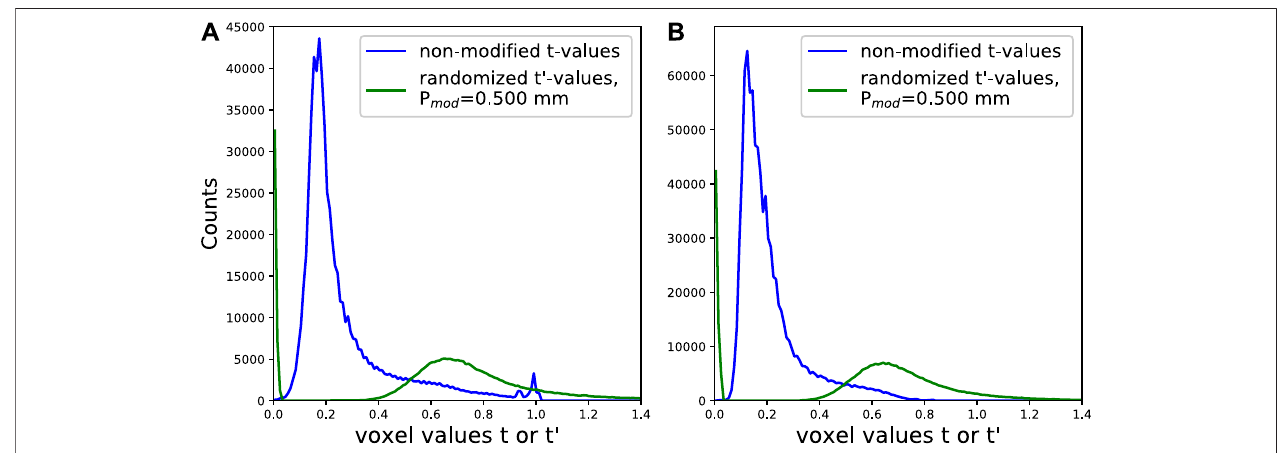
FIGURE1| HistogramoftheWEPLvoxelvaluesinthebeamdirectionoftheoriginalCT( t valuesinblue)andafterapplicationoftherandomizationvoxelmodulation routine( t ′ valuesingreen)for (A) patientP1,and (B) P2,withrespectivelylargeandsmallPTVsizes(fordetails,seepatient selectionsubsection).Thebinsat t ′ (cid:1) 0forthe modulated functions are divided by 10 not to dilute the plot. VOI lung was equal to all voxels in the ipsilateral lung, meaning no ρ range parameter value was used.